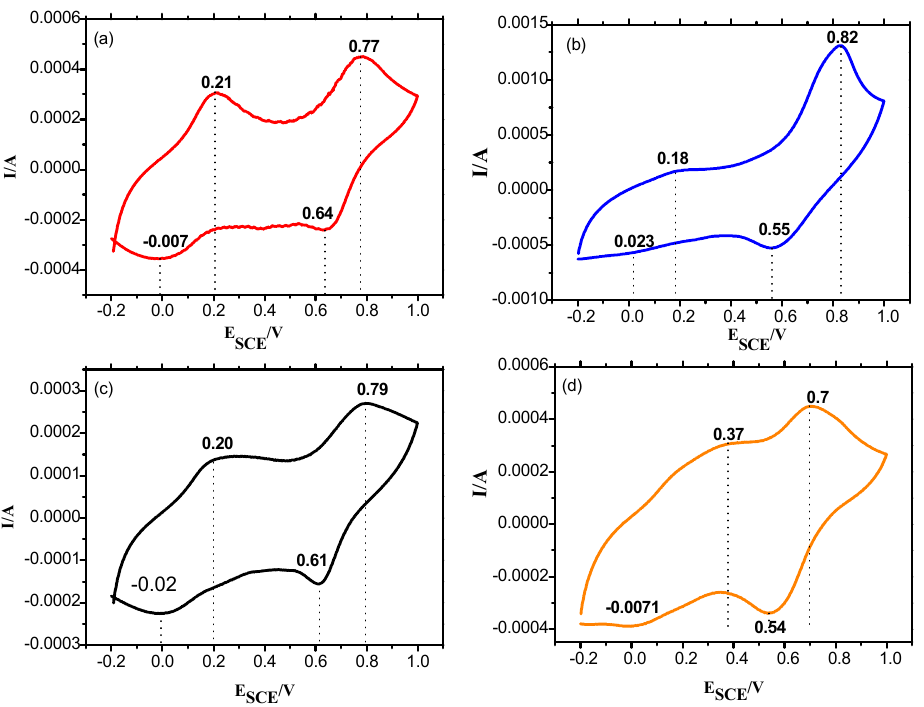
Figure 10. CV of synthesized PANI samples coated on a gold sheet electrode, in 0.5 M H 2 SO 4 at a scan rate of 50 mV / s ( a ) PANI A4 ( b ) PANI B9 ( c ) PANI D2 ( d ) PANI S3.